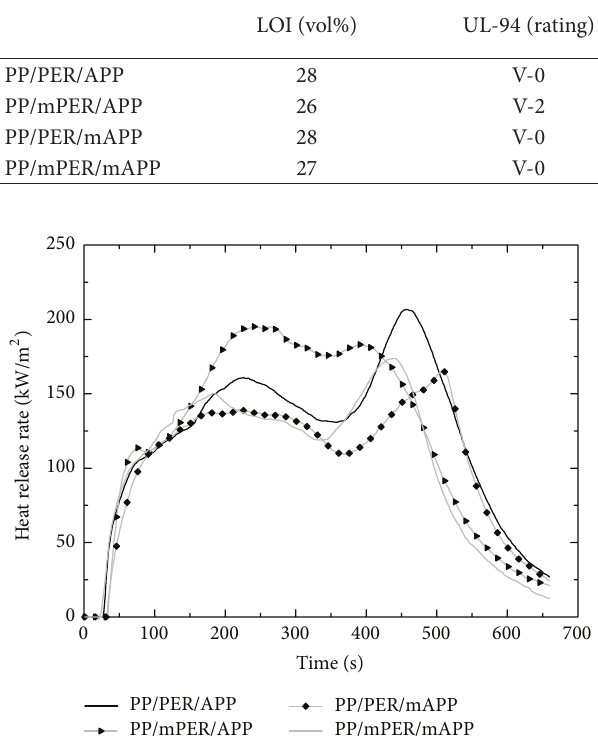
Figure 4: Heat release rate curves of intumescent flame retarded PP